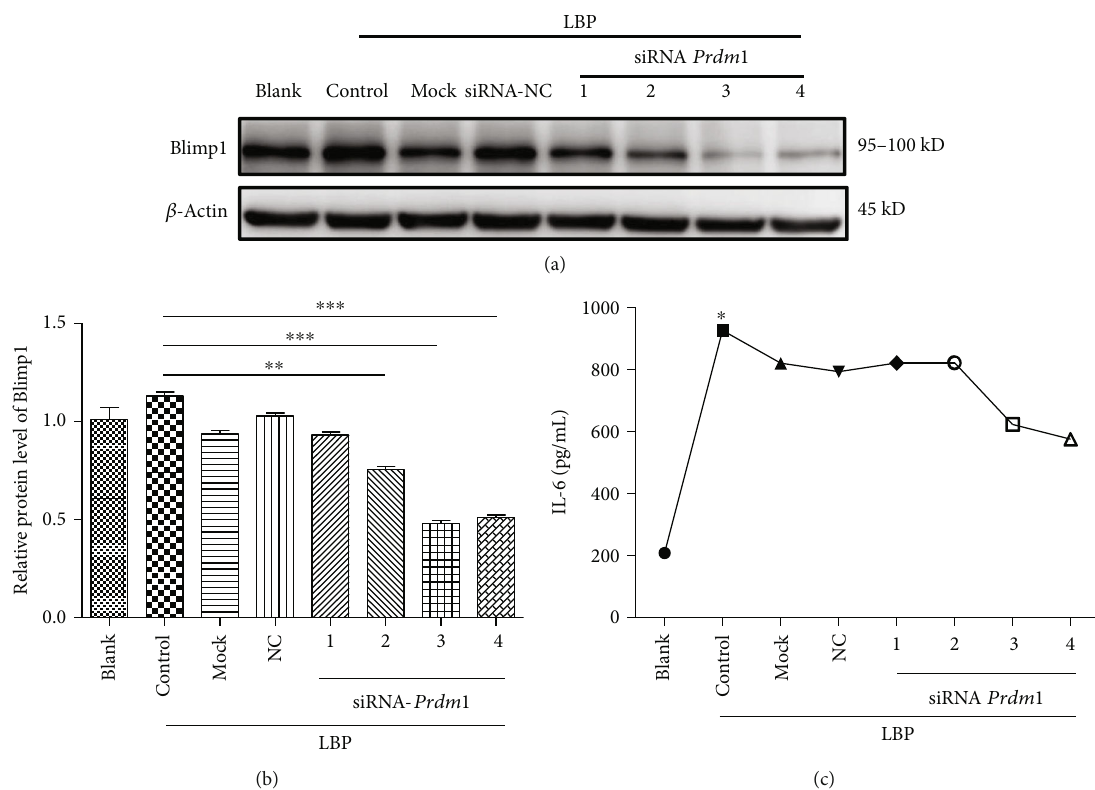
Figure 6: Gene silencing in LBP induced DCs using Blimp1-speci fi c siRNA. DCs were transfected with siRNA- Prdm1 -1, siRNA- Prdm1 -2, siRNA- Prdm1 -3, siRNA- Prdm1 -4, siRNA-NC, reagent alone (mock-treated), or nontransfected cells (control). After coculture of transfected DCs with LBP for 24h, the expression of Blimp1 was detected by Western blot (a and b), and the IL-6 concentration in the culture supernatant was detected by ELISA (c). β -Actin expression was treated as internal reference. Values are the mean and SD of 3 independent experiments. ∗ P < 0 : 05 , ∗∗ P < 0 : 01 , and ∗∗∗ P < 0 : 001 versus